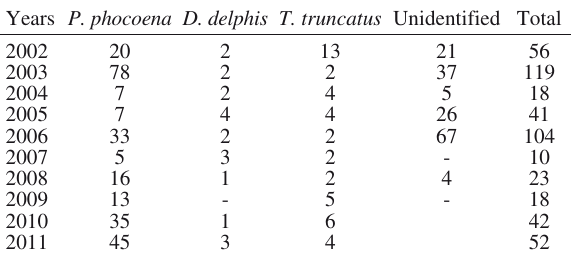
Table 2. – Stranded (beached) cetaceans recorded on the Romanian littoral during the past 10 years